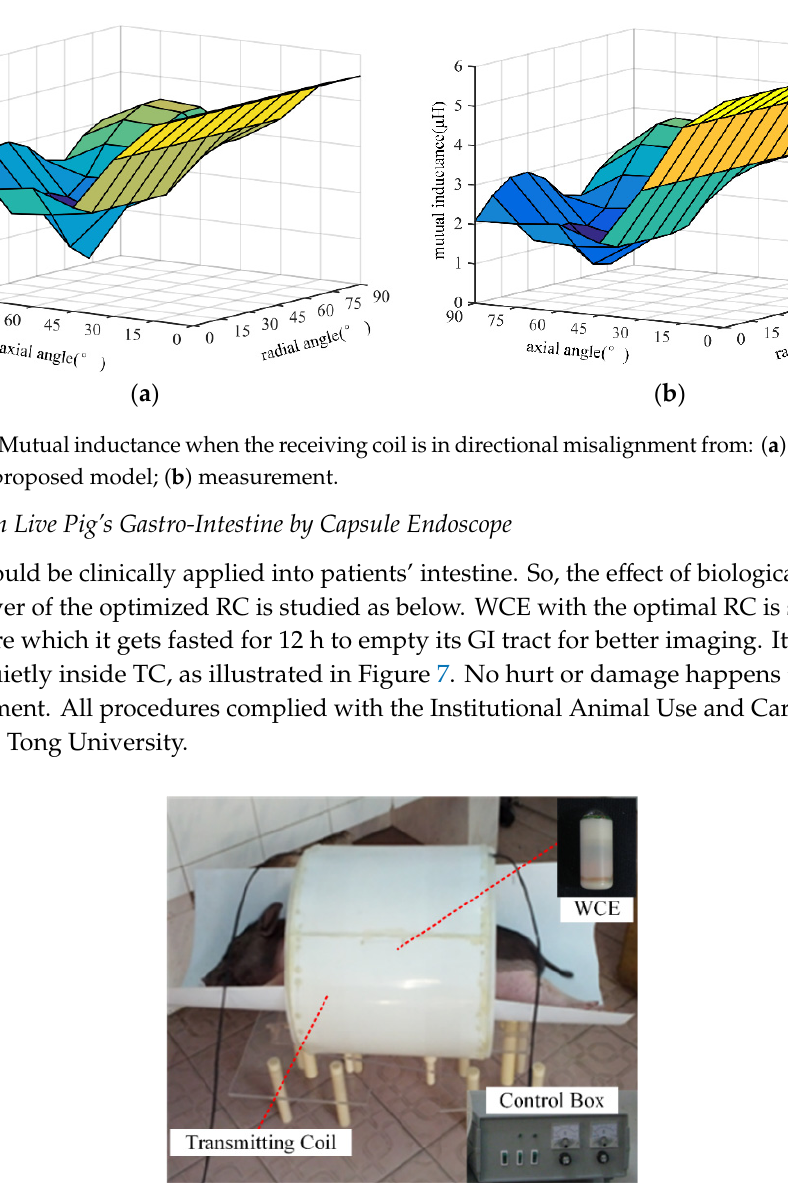
Figure 5. The Setup for measuring mutual inductance when the receiving coil is in different directions.